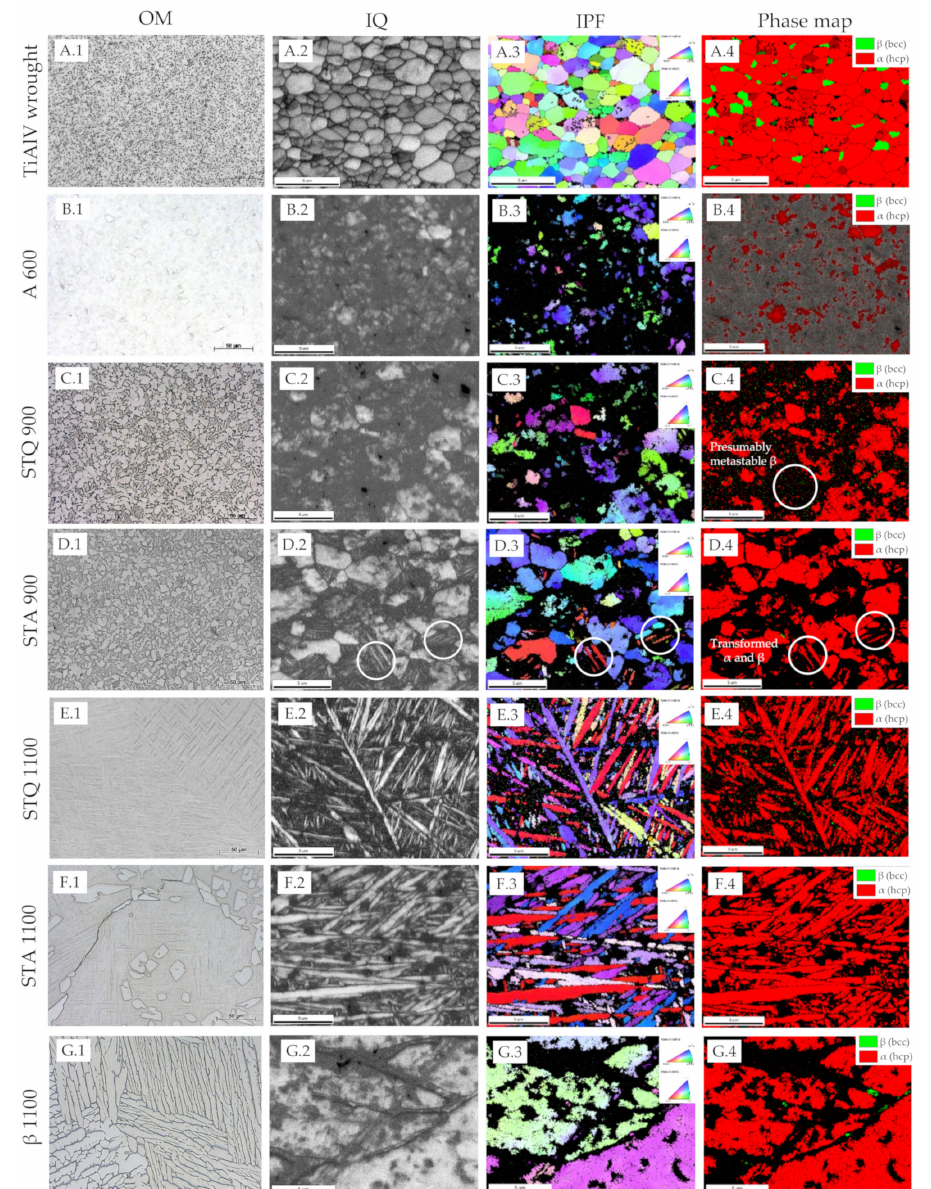
Figure 2. Micrographs and corresponding EBSD results of different conditions of the TiAl6V4 alloy. ( A ) Initial condition of TiAl6V4 wrought alloy and ( B ) aged condition (A 600) at 600 ◦ C for 30 min of former wrought alloy. ( C ) Solution-treated at 900 ◦ C and quenched sample (STQ 900) and ( D ) subsequently aged sample (STA 900). ( E ) Sample after solution treatment at 1100 ◦ C (STQ 1100) and ( F ) afterwards aged (STA 1100). ( G ) β annealed sample previously solution-treated at 1100 ◦ C with partial furnace cooling ( ββ 1100). Different representations of the present microstructure are displayed in each column: ( A.1 – G.1 ) digital optical images, measured EBSD data as ( A.2 – G.2 ) image quality map (IQ) illustrates grain boundaries, ( A.3 – G.3 ) inverse pole figure (IPF) map indicates the crystallographic orientation of the grains and ( A.4 – G.4 ) color-coded phase map of the present crystal structure (hcp in red, bcc in